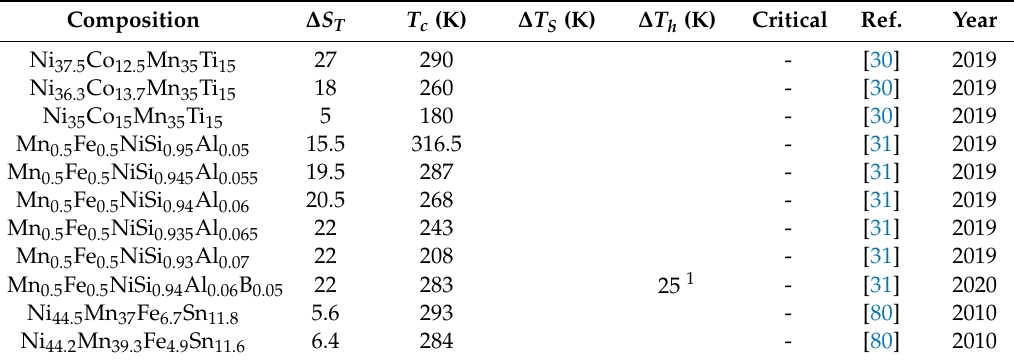
Table 1. Composition (with critical or undesired elements, if any), caloric response ∆ S T (J kg − 1 K − 1 ) and ∆ T S (K) at 2 Tesla magnetic field change, phase transition T c (K), and hysteresis width ∆ T h (K).